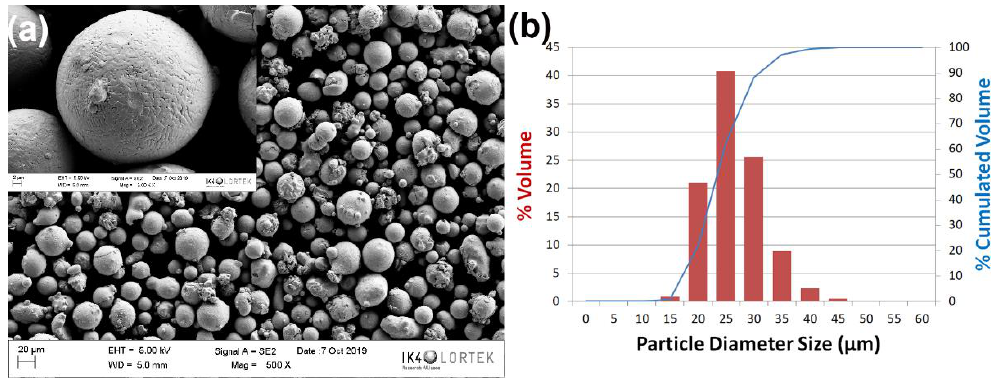
Figure 4. IN718 pre-alloyed powder. ( a ) Morphology of the particles in SEM image (20 kV) and ( b ) granulometry and distribution analysis.